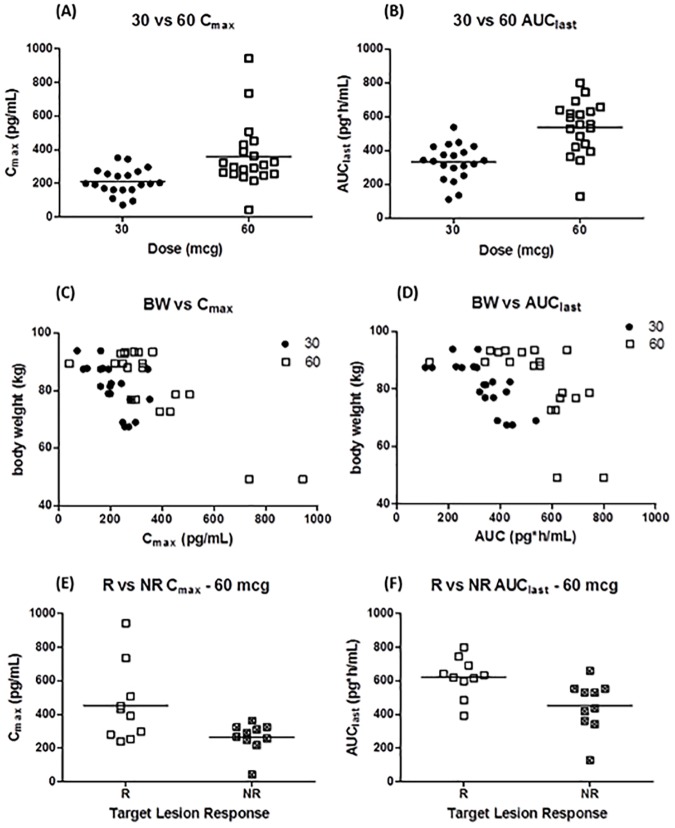
Pharmacokinetic analyses.Individual values for total drug exposure based on mean Cmax (A) and AUClast (B) for both the 30mcg/dose group (closed circles) and the 60mcg/dose group (open squares). Individual drug exposure levels correlated with body weight for Cmax (C) and AUClast (D). Individual drug exposure levels from the 60 mcg/dose group separated by those who had an improvement in target lesion response, responders (open square), vs those who did not yet show improvement, nonresponders (hatched square) based on Cmax (E) and AUClast (F).